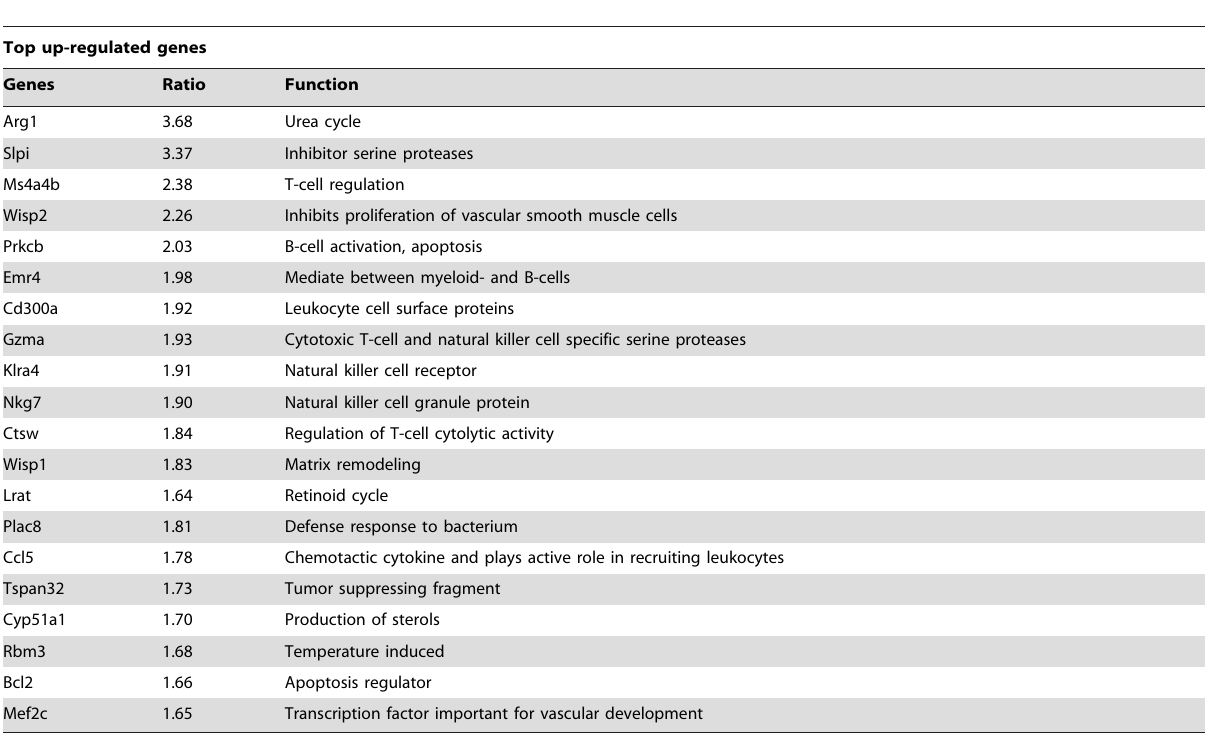
Table 2. The most significantly up-regulated genes in adult Fibulin-4 R/R lungs. Genes are indicated with their ratios compared to Fibulin-4 + / + lungs and the process